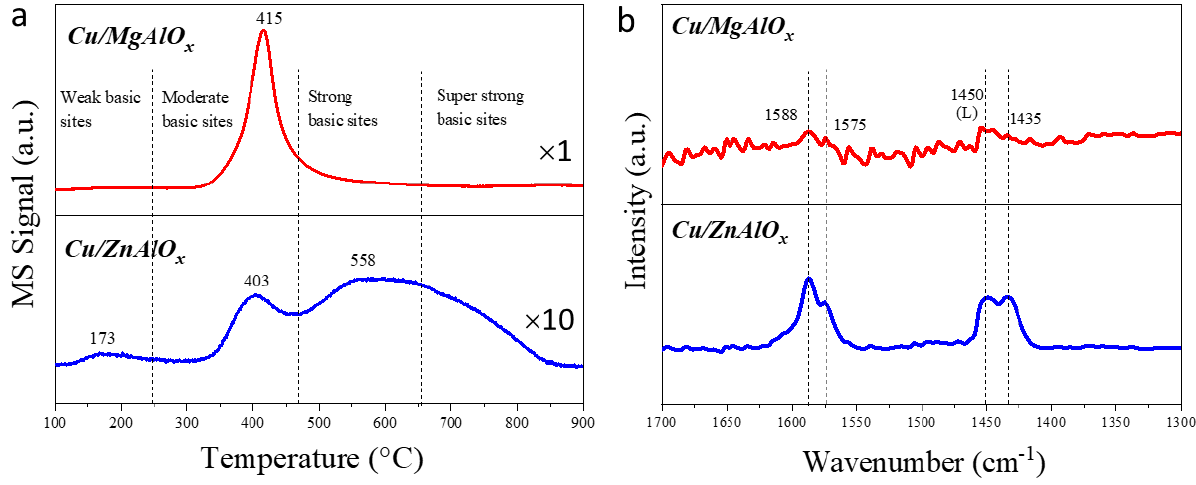
Figure 6. ( a ) CO 2 TPD profile and ( b ) pyridine adsorbed FT-IR spectra of the supported Cu cata- lysts.